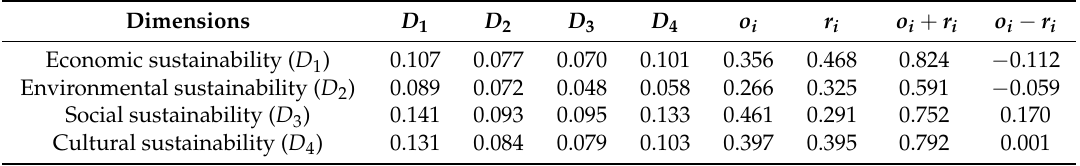
Table A3. The total influence matrix of criteria T D and sum of influences given/received on